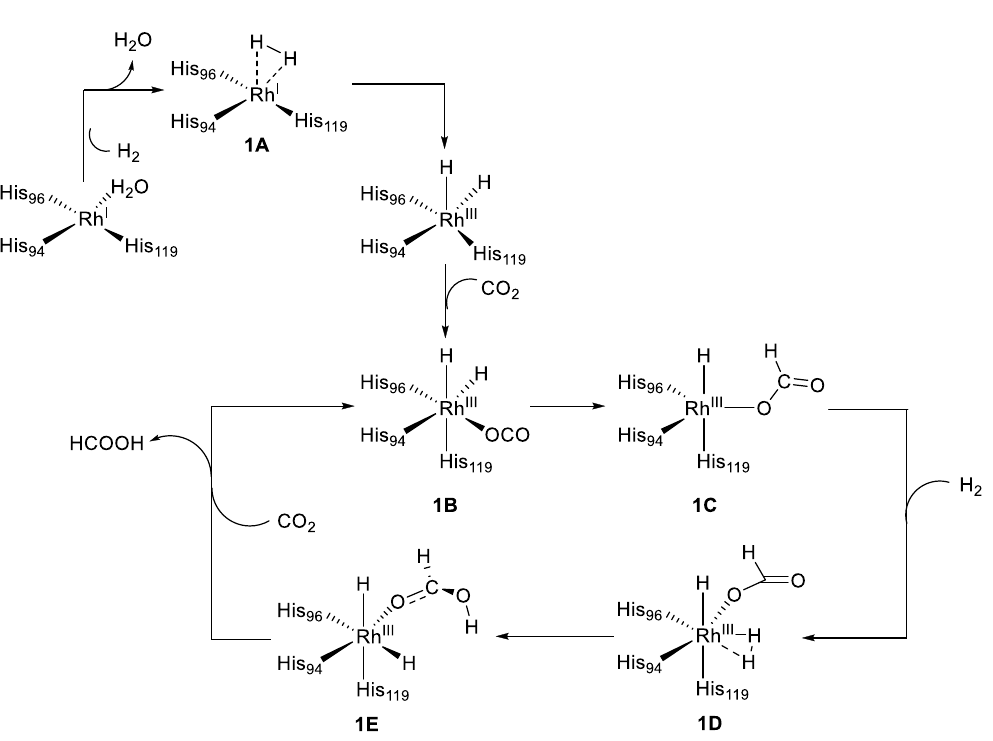
Figure 6. Proposed mechanism for the reduction of CO 2 with Rh-CA.